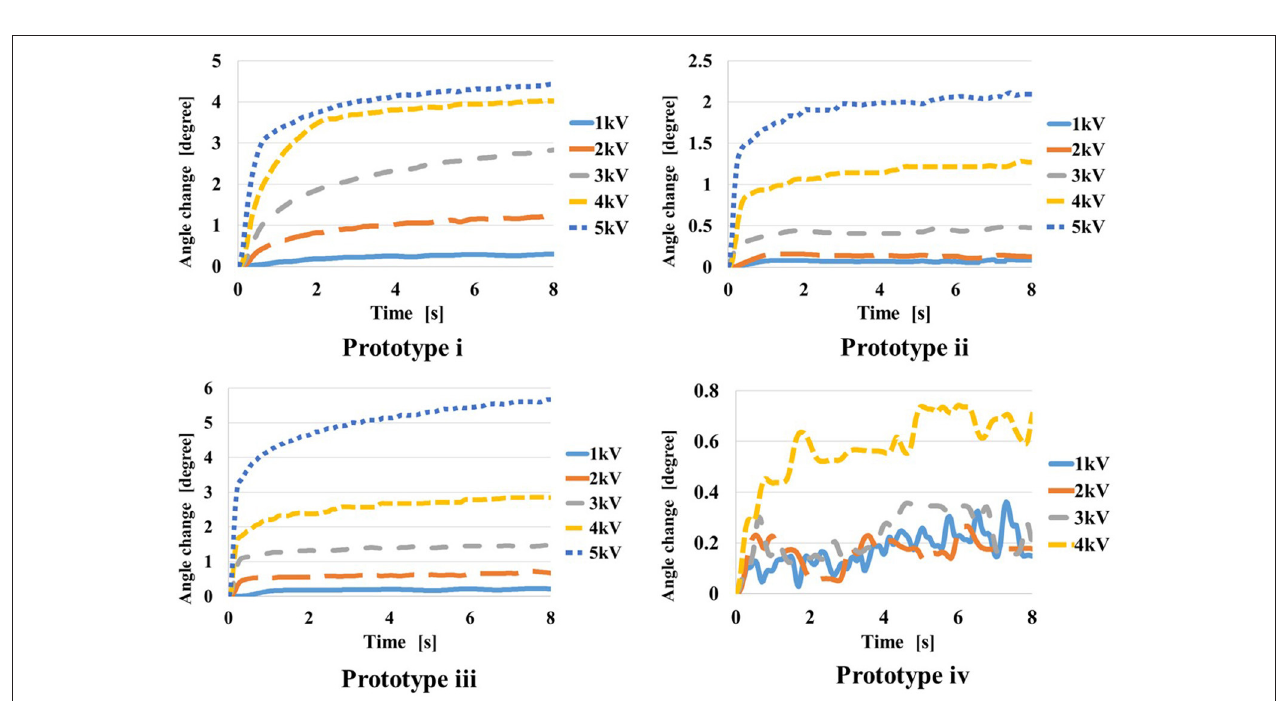
FIGURE 11 | Result of applying DC voltage to each